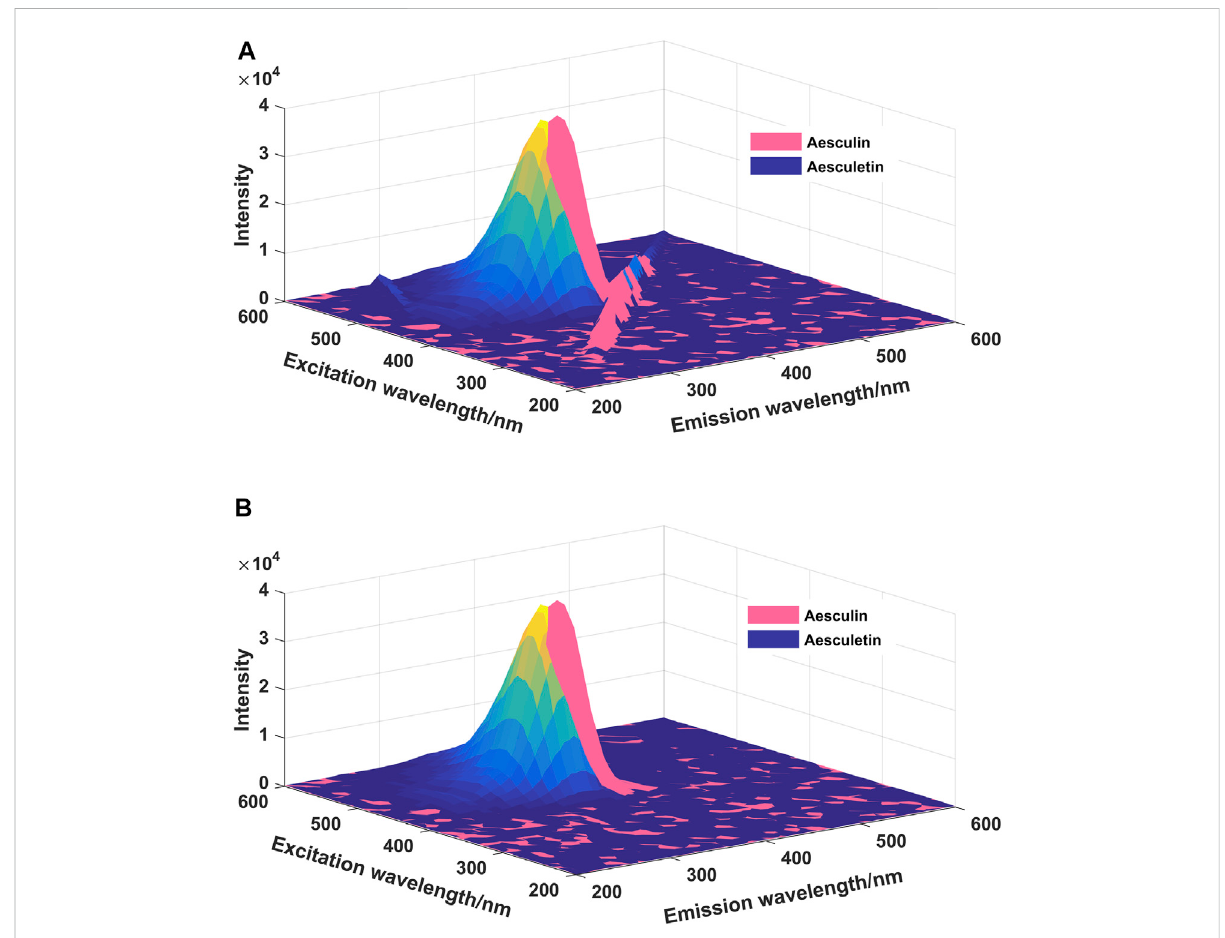
FIGURE 2 The EEM spectra of aesculin (0.16 μ g/ml) and aesculetin (1 μ g/ml). (A) : Scatterings are not eliminated; (B) : Scatterings are